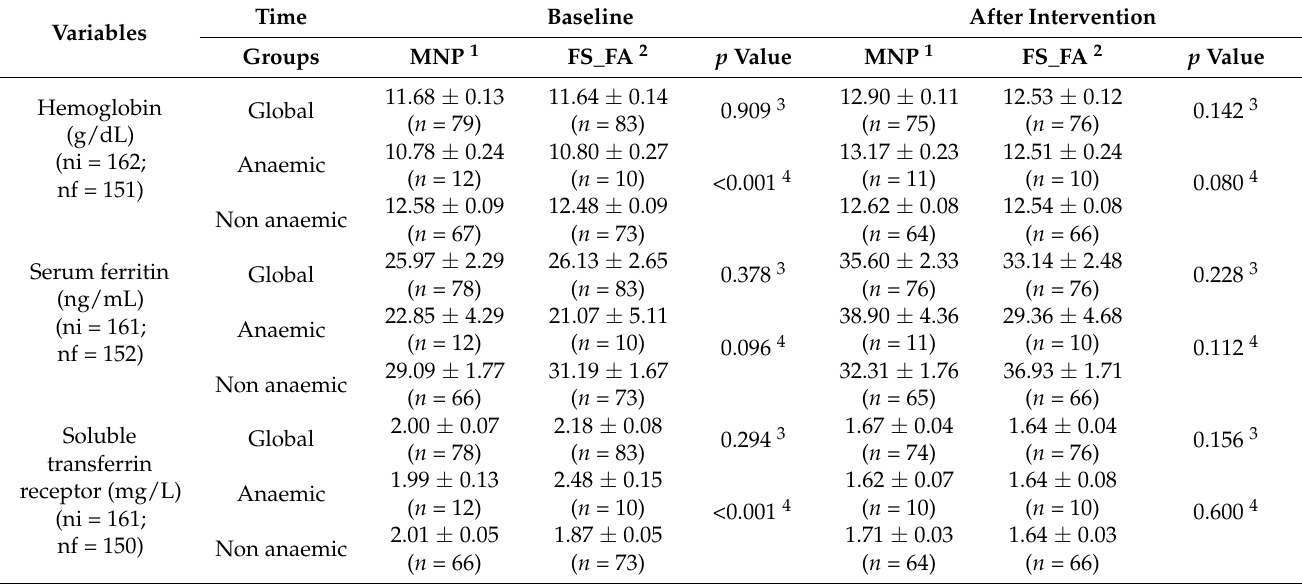
Table 3. Hemoglobin, serum ferritin, and soluble transferrin receptor means at baseline and after intervention. Time Baseline After Intervention Variables Groups MNP 1 FS_FA 2 MNP 1 p